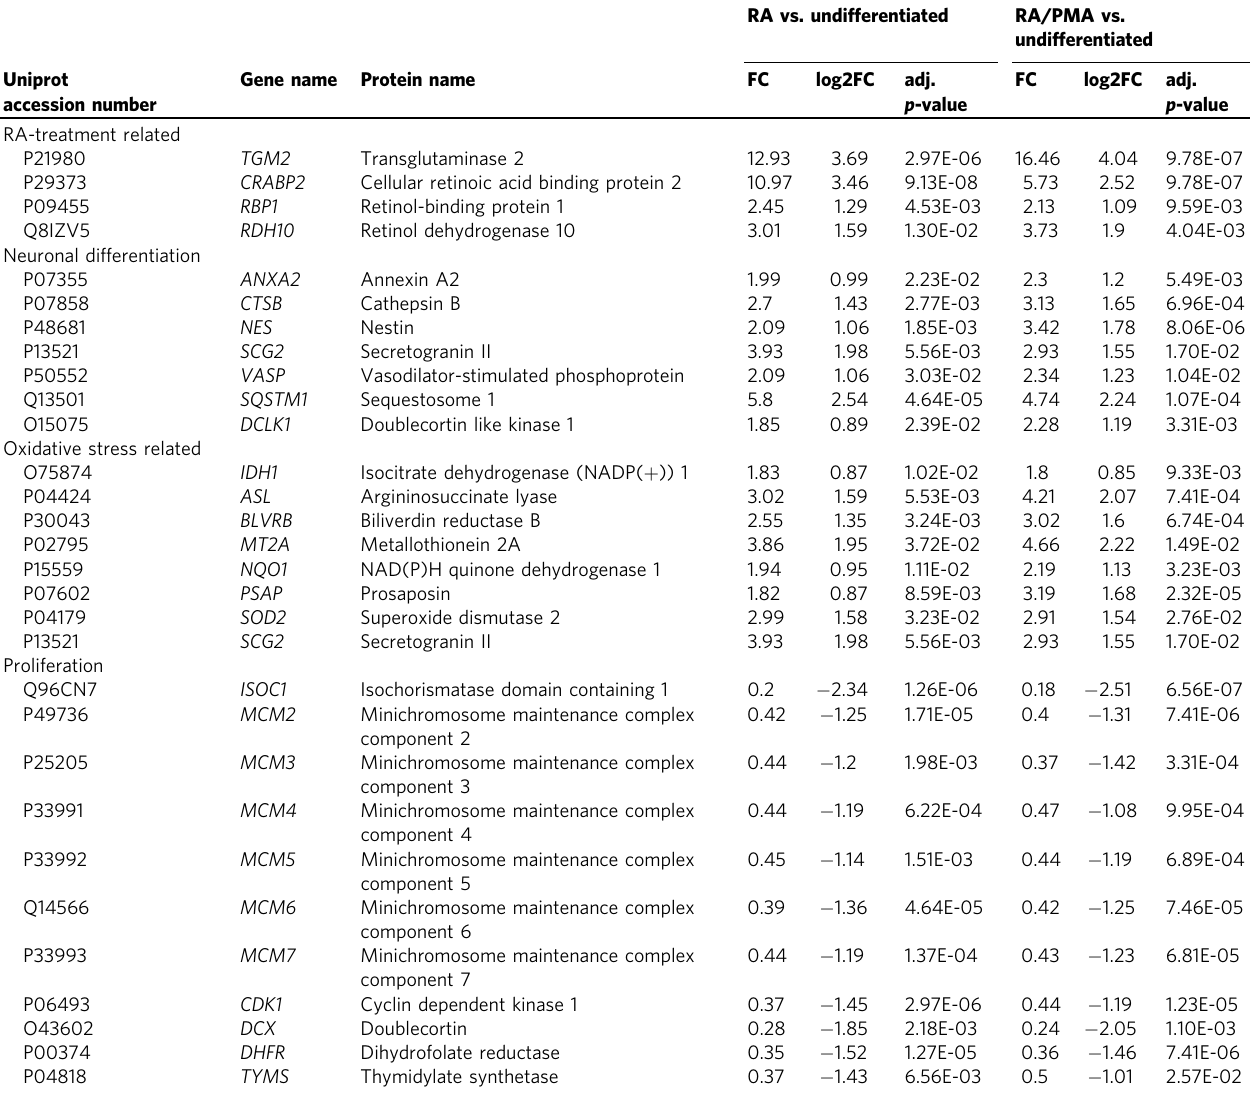
Table 1 Changes in protein expression upon differentiation.